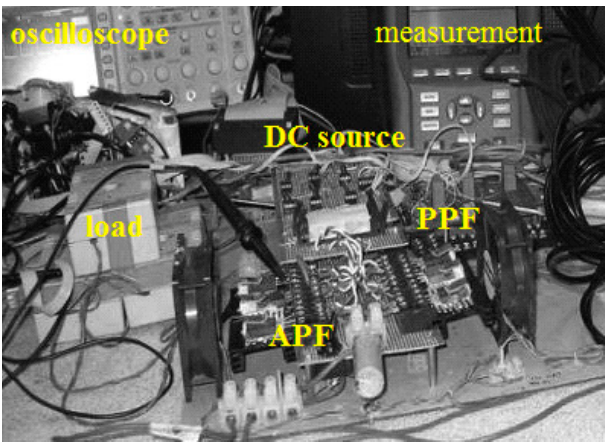
Figure 5. Proposed APF prototype used in laboratory tests. Table 1. Prototype specifications. PPF: passive power filter.